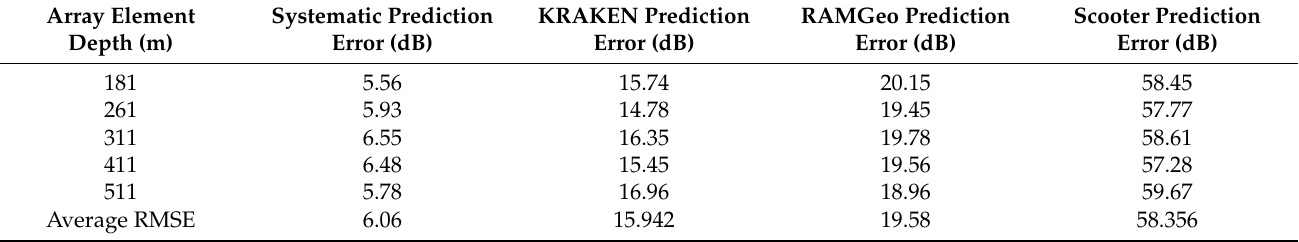
Table 9. RMSE error comparison (600–800